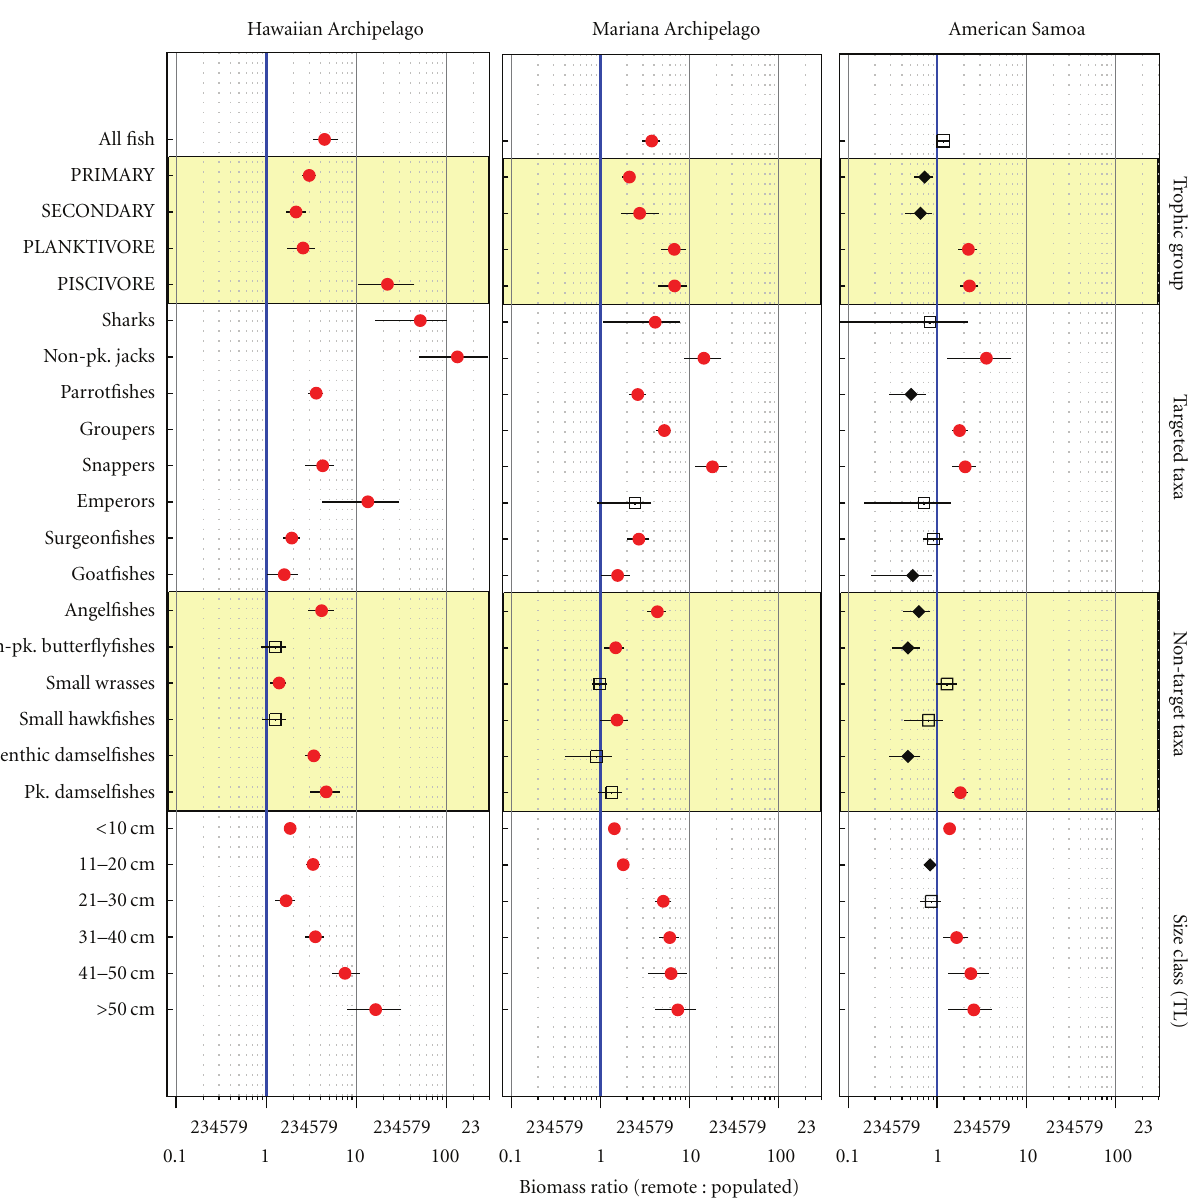
Figure 3: Di ff erences in reef fish assemblages between remote and populated portions of US Pacific coral reef regions. Di ff erences are given as the ratio of biomass between remote and human-populated portions of each region. The blue vertical line represents a ratio of one (i.e., no di ff erence in biomass between remote and populated reef-areas). Horizontal bars indicate 95% quantile-range. Red circles: higher biomass at remote reef-areas; that is, positive biomass ratio and 95% quantile-range do not overlap one. Black diamonds: lower biomass at remote reef-areas; that is, ratio is negative and quantile-range does not overlap one. Open squares: 95% quantile-range overlaps one. Details of the analysis are given in Section